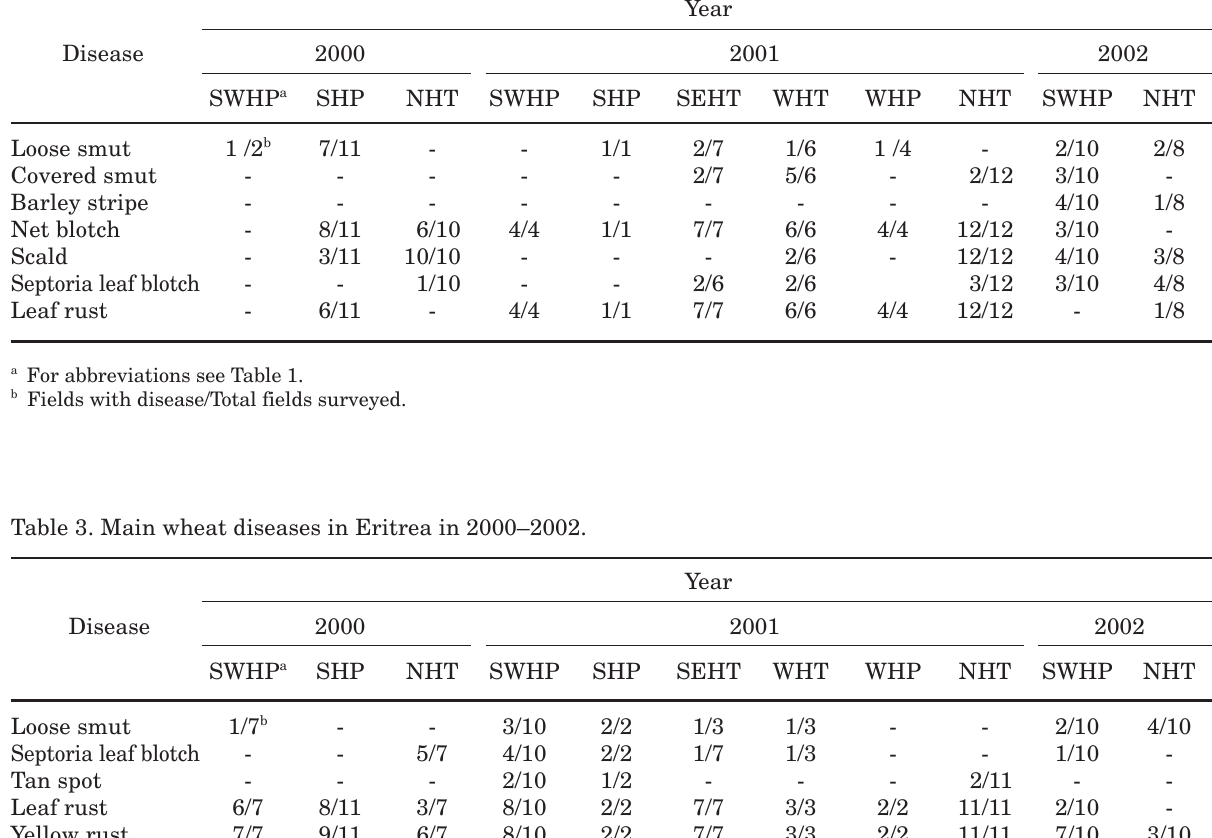
Table 2. Main barley diseases in Eritrea in 2000–2002.